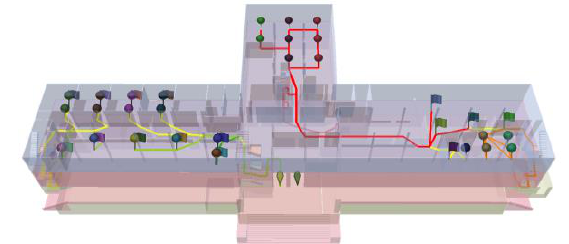
Figure 22. Generated Evacuation Ground Floor Routes for